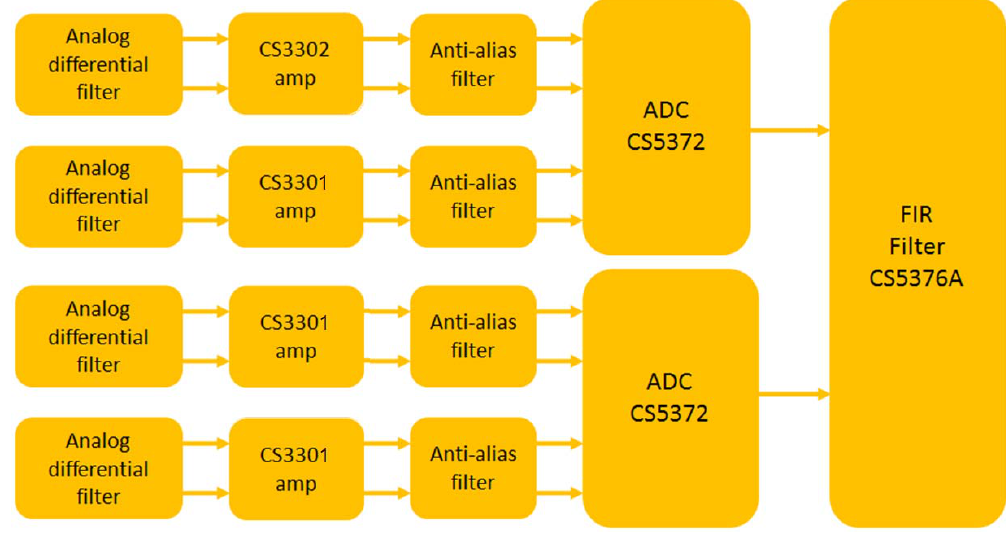
Figure 17. Block diagram of the ADC